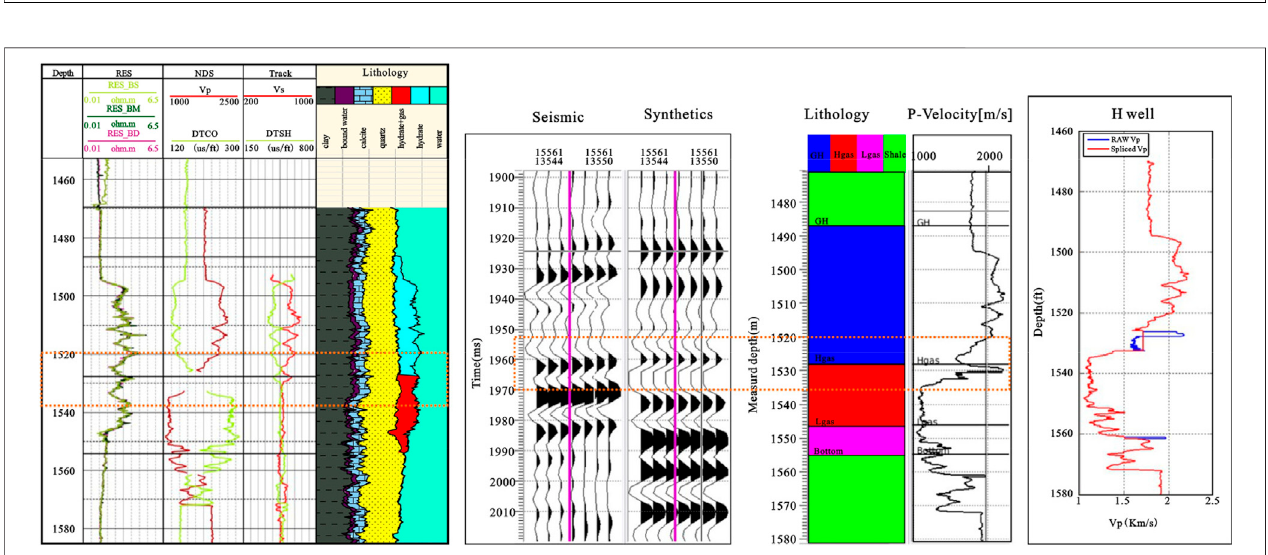
FIGURE 16 | Diagram of calibrating downhole seismic in Well H (after